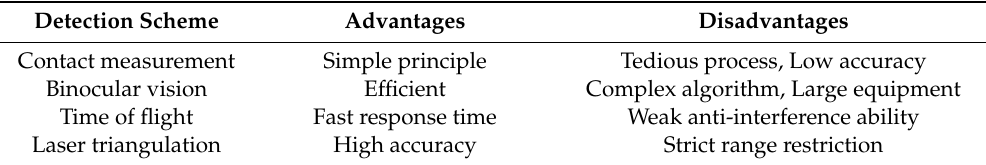
Table 1. Comparison of detection schemes.